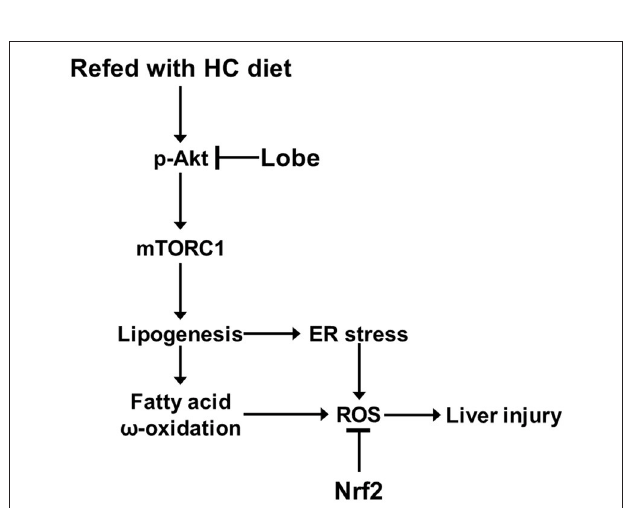
FIGURE 8 | Model for mechanism of protective action of lobeglitazone against the liver injury. See text for details. β oxidation through the inhibition of CPT-1, resulting in